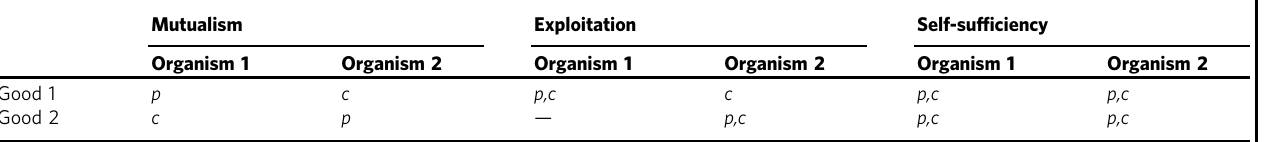
Table 1 Classi fi cation of microbial exchange between two organisms involving two